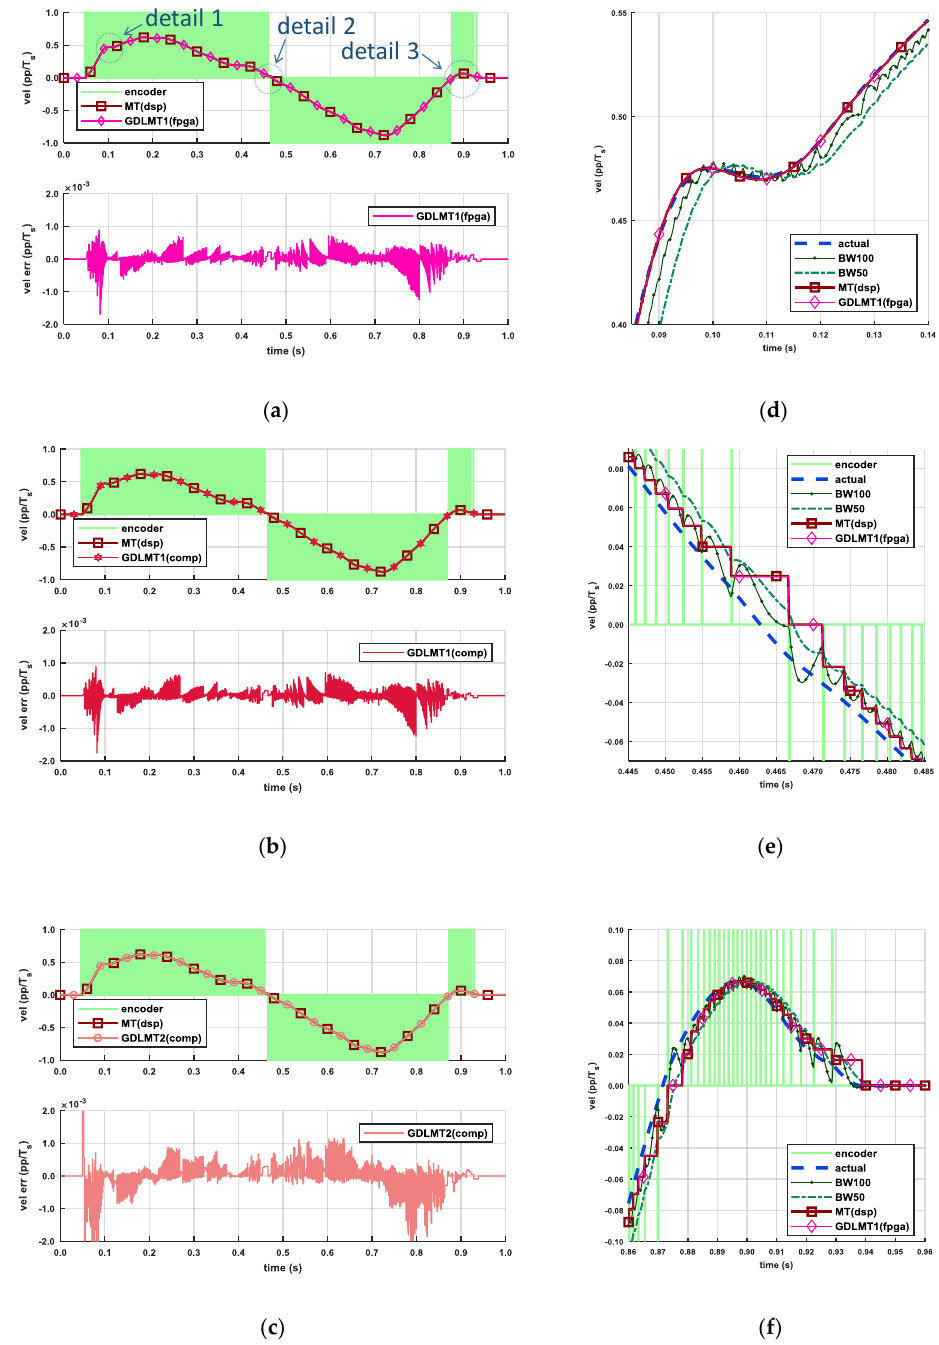
Figure 12. Manual experiment number 2: ( a ) Comparison of the MT velocity and the GDLMT1 velocity (FPGA version); ( b ) Comparison of the MT velocity and the GDLMT1 velocity (computer version); ( c ) Comparison of the MT velocity and the GDLMT2 velocity; ( d )–( f ) Details 1 to 3 from (a).